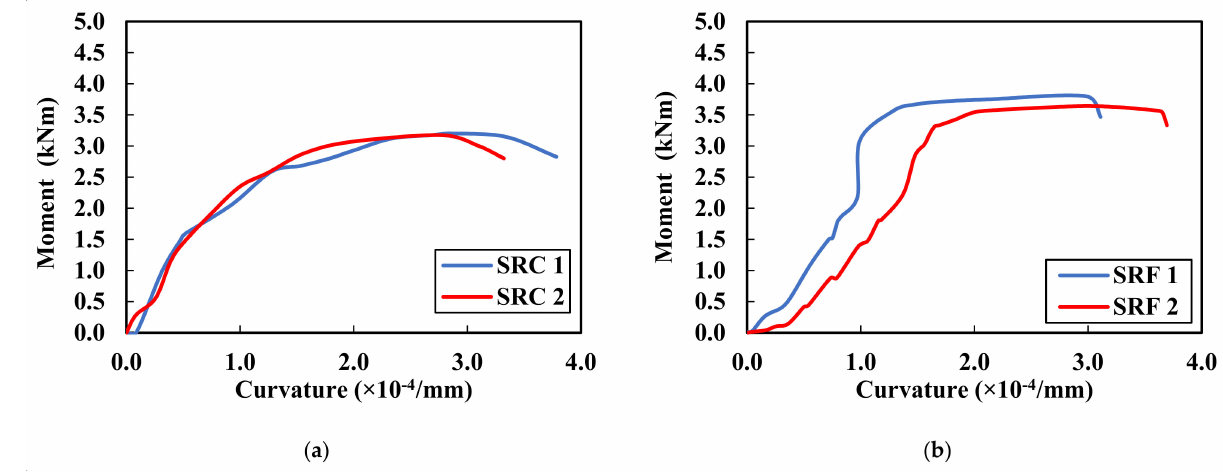
Figure 12. Moment–curvature behavior of ( a ) SRC and ( b ) SRF.